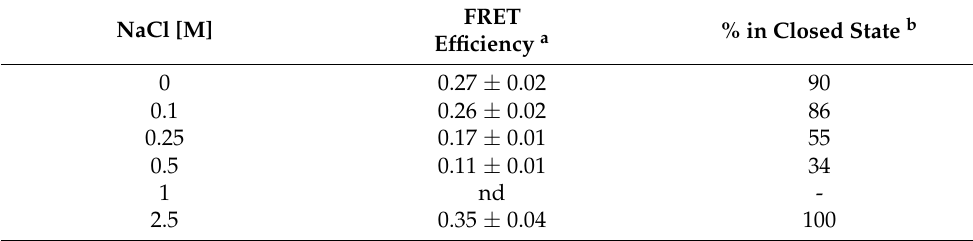
Table 4. FRET efficiencies (E) determined for the double labeled TOP -Trp W390/Y224 p NF mutant at different concentrations of NaCl. The fraction of the mutant in the closed state, calculated assuming that TOP has only two possible conformations, open and closed, are also